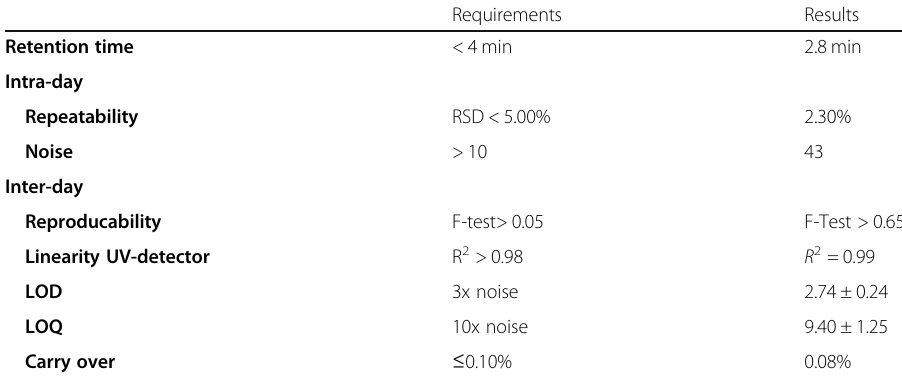
Table 1 Parameters required for the validation of the HPLC method Requirements